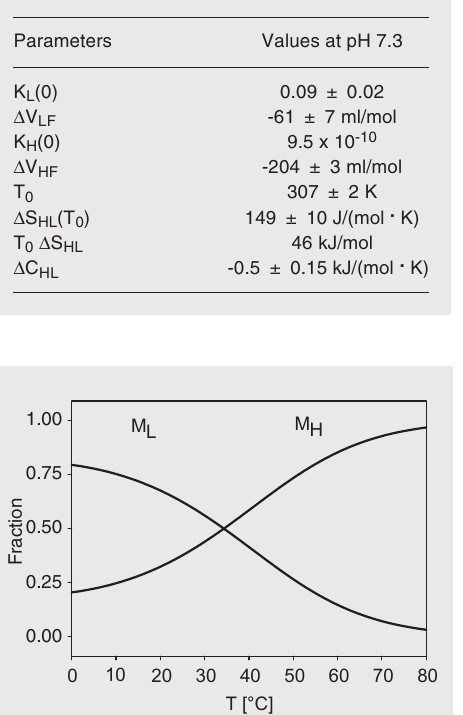
Table 1. Parameters of simultaneous fit to the model of Equation 3.